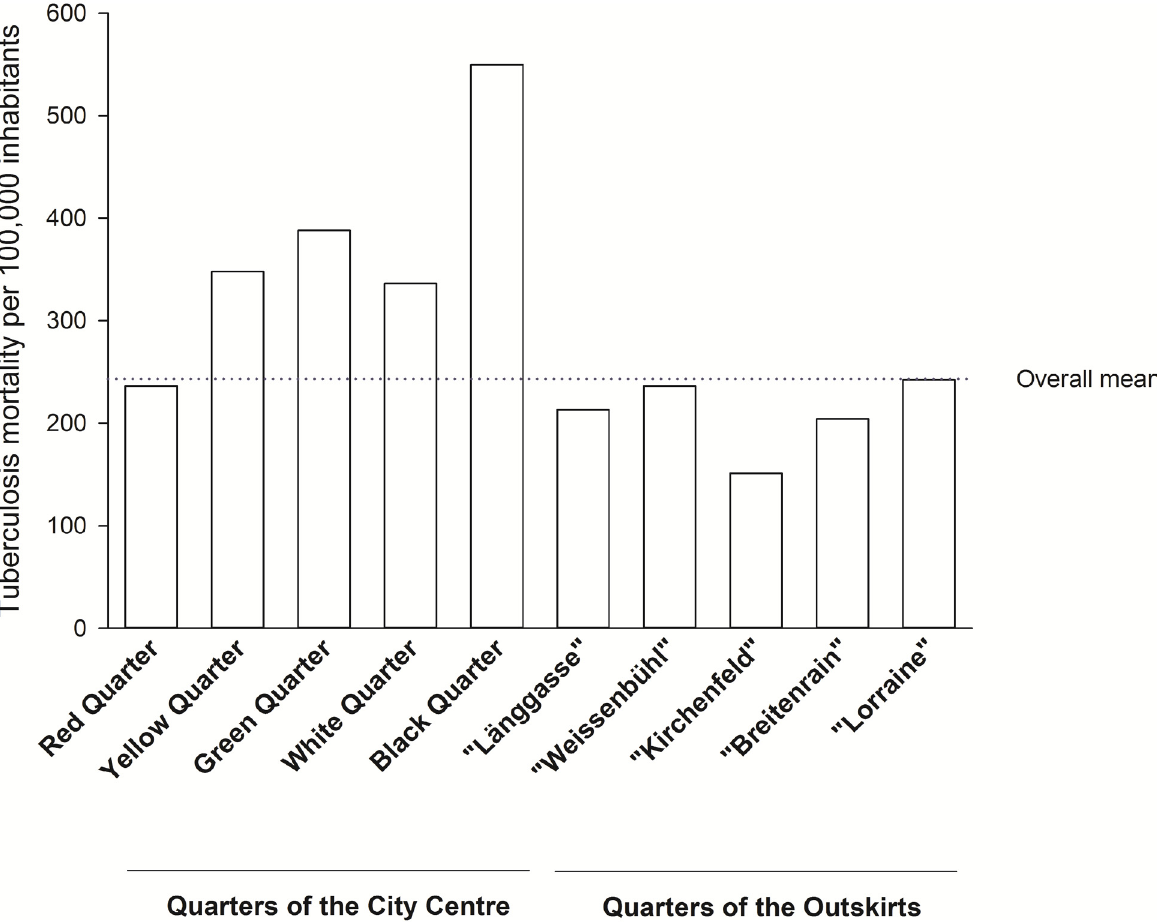
Fig 2. TB mortality by quarter in the city of Bern, Switzerland, between 1911 and 1915. Bern consisted of five quarters in the City centre including the “ Black Quarter ” (named after colours since the Napoleonic occupation), and five quarters in the city